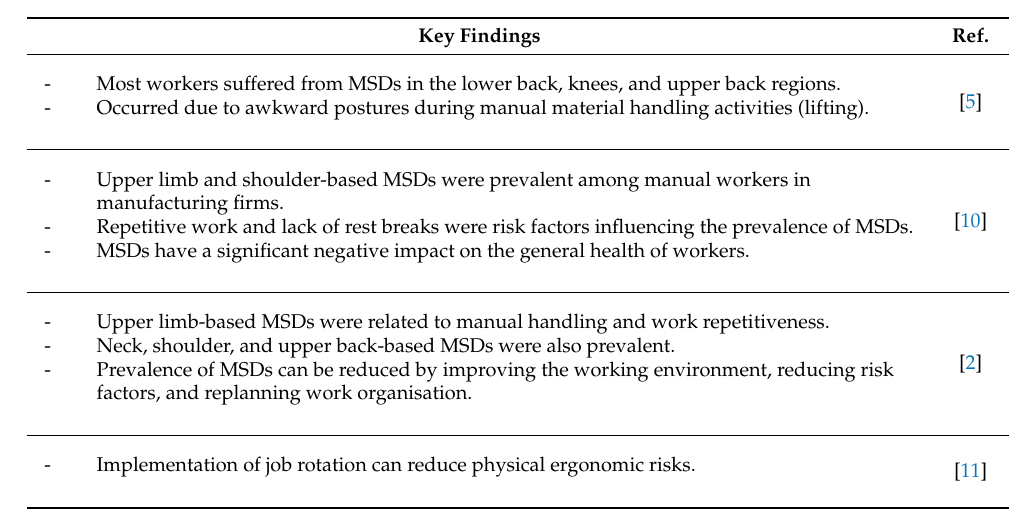
Table 1. Summary of key findings of past studies on MSDs.